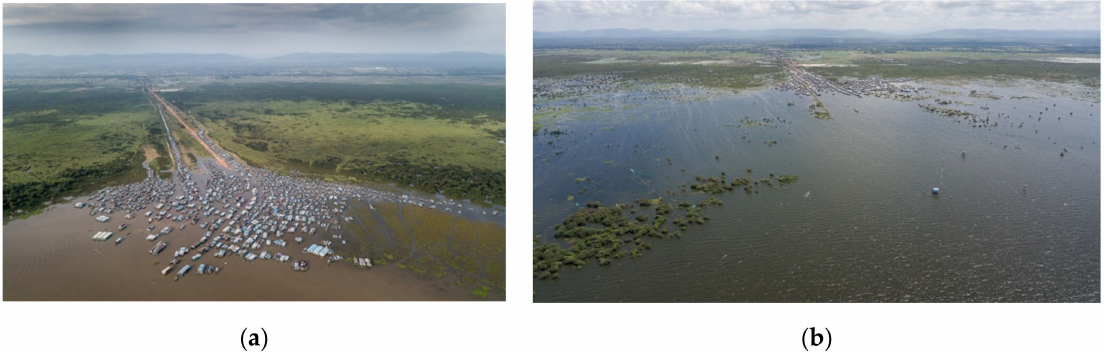
Figure 4. Two pictures of the Kampong Luong floating village in Pursat Province on Tonle Sap Lake by photographer Suthep Kritsanavarin shared on WOM social media. ( a ) Photo taken in June at the beginning of the rainy season; ( b ) photo taken in September. On average, the village moves back as far as three kilometers during the rainy